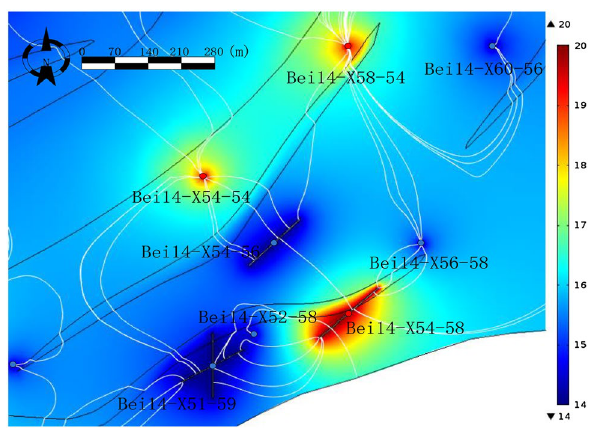
Fig. 7 Bei 14-X51-59 near the well